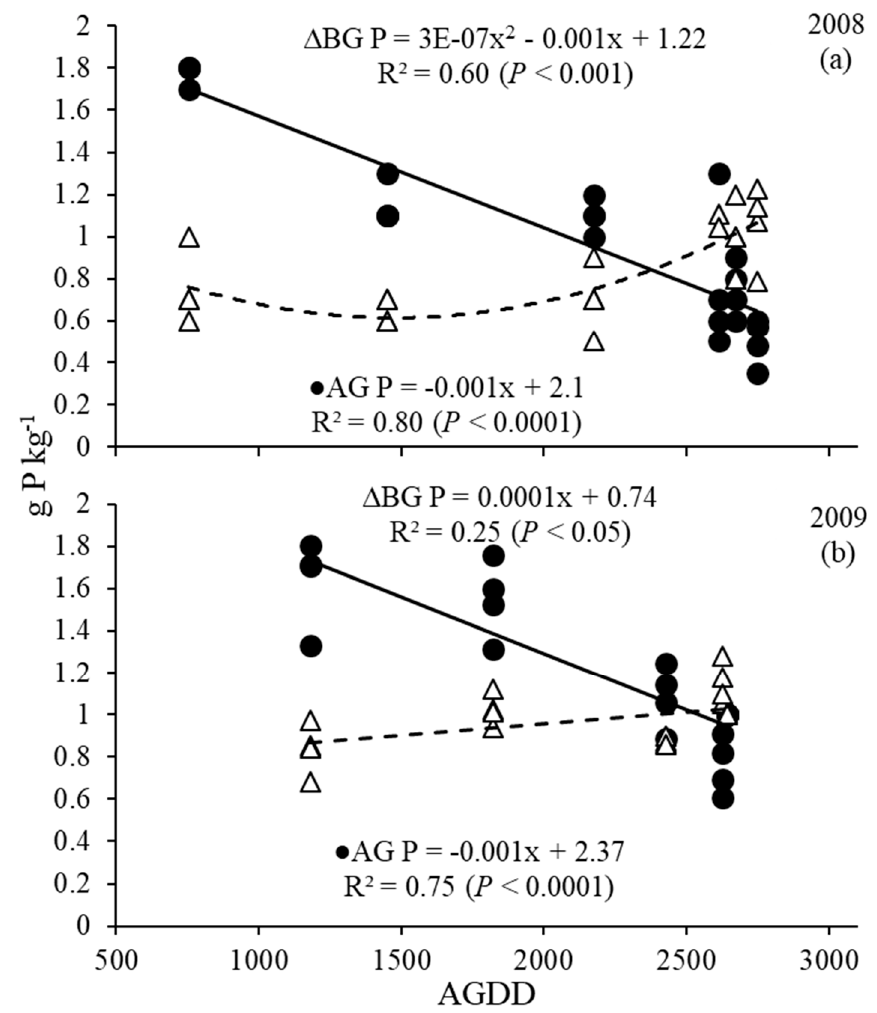
Figure 5. Switchgrass above (AG) and belowground (BG) phosphorus concentration (g P kg − 1 ) as a function of AGDD (accumulated growing degree days) harvests in 2008, 2009 and 2010.